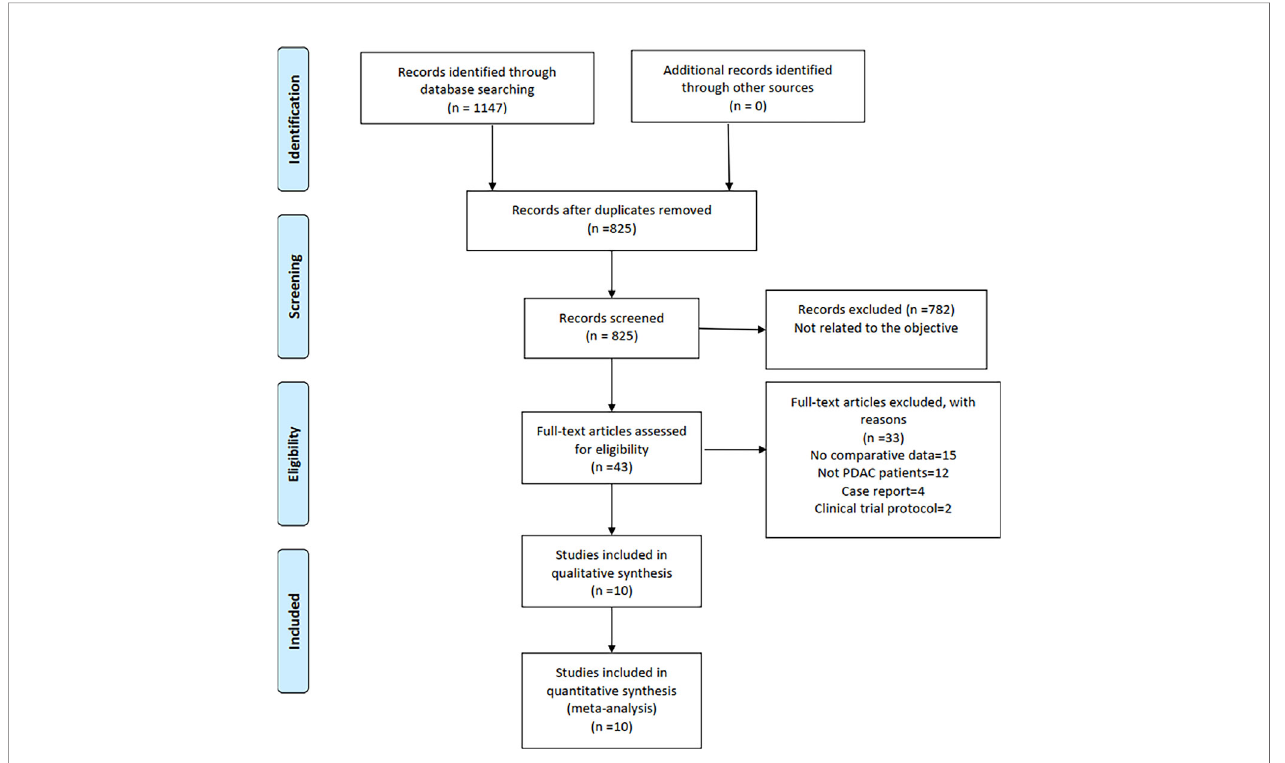
FIGURE 1 | Flowchart of study identi fi cation and